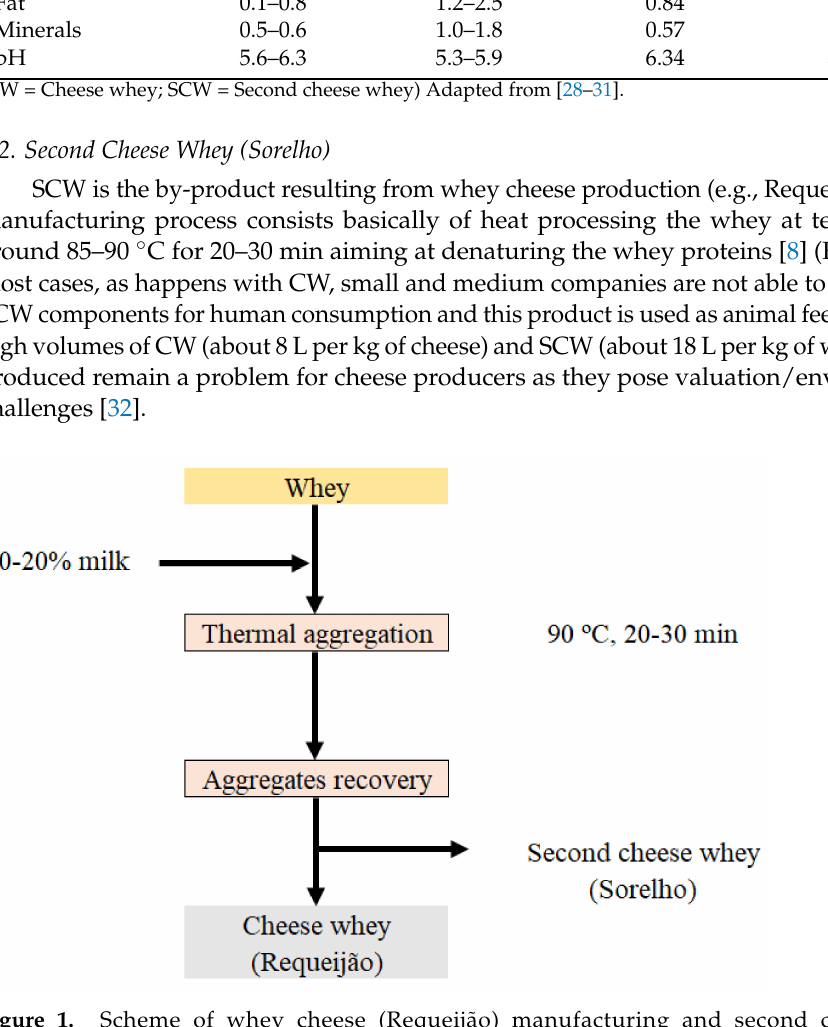
Figure 1. Scheme of whey cheese (Requeij ã o) manufacturing and second cheese whey (Sorelho)